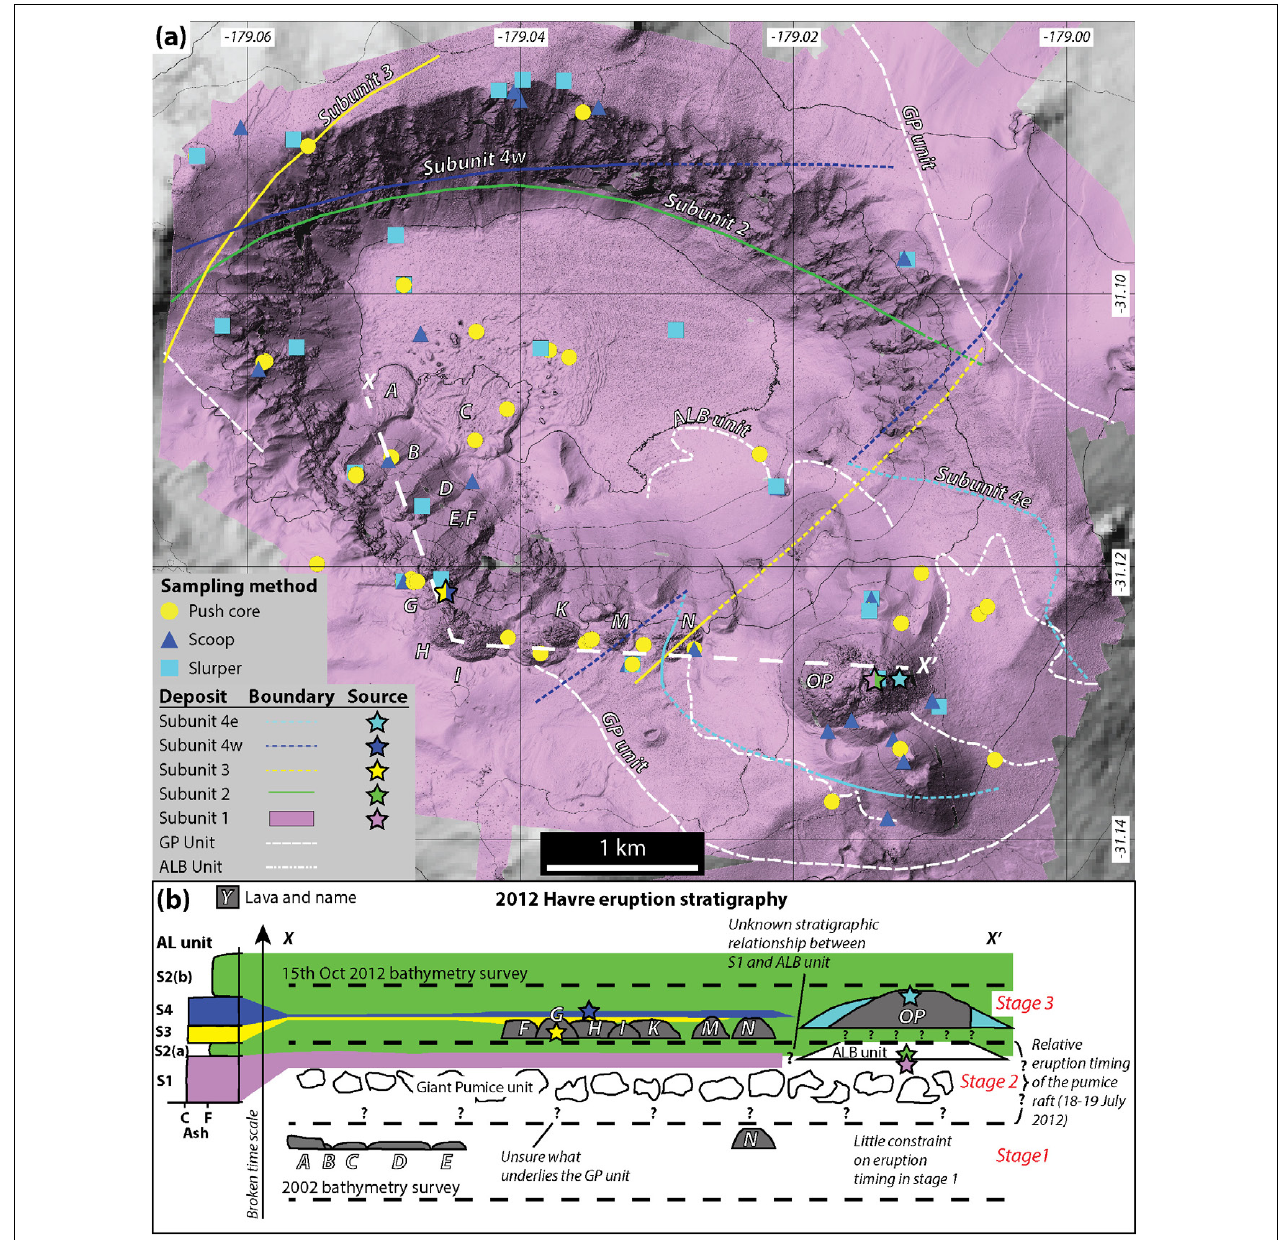
FIGURE 10 | (a) Bathymetric map showing Havre caldera along with the distributions/outlines of the clastic deposits produced during the 2012 Havre eruption where: GP unit – white dashed, ALB unit – white dash and dots, S2 – green, S3 – yellow, S4w – dark blue, and S4e – light blue. Solid line indicates a deposit boundary constrained by sample characteristics, while the dashed boundary are constrained by bathymetry, seafloor texture, etc. Subunit 1 (purple) is present at all sample sites with no change in thickness or grainsize, and is interpreted to extend well beyond AUV-mapped area. The inferred locations of the sources for each subunit are denoted by stars. (b) An idealized stratigraphic cross section through the Havre eruption deposits [generalized location shown on (a) ] showing temporal and spatial relations of deposits from various vents. Three stages have been identified for the Havre eruption reflecting changes in style and location, from dispersed effusive to fragmental eruption focused on a single vent, then to dispersed effusive with weakly pyroclastic